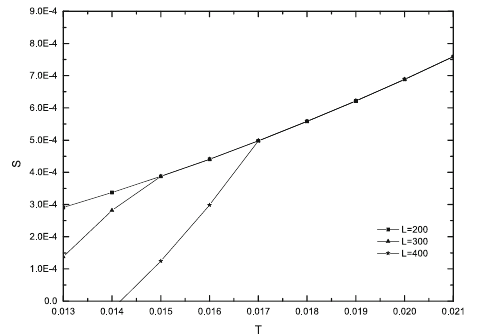
Fig. 5 The dependence of entropy on the temperature with several volume size in the chiral limit